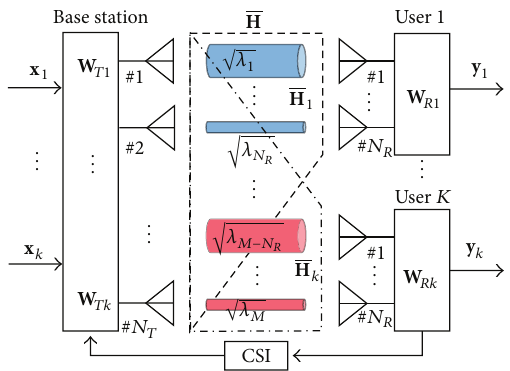
Figure 1: System model for downlink MU-MIMO